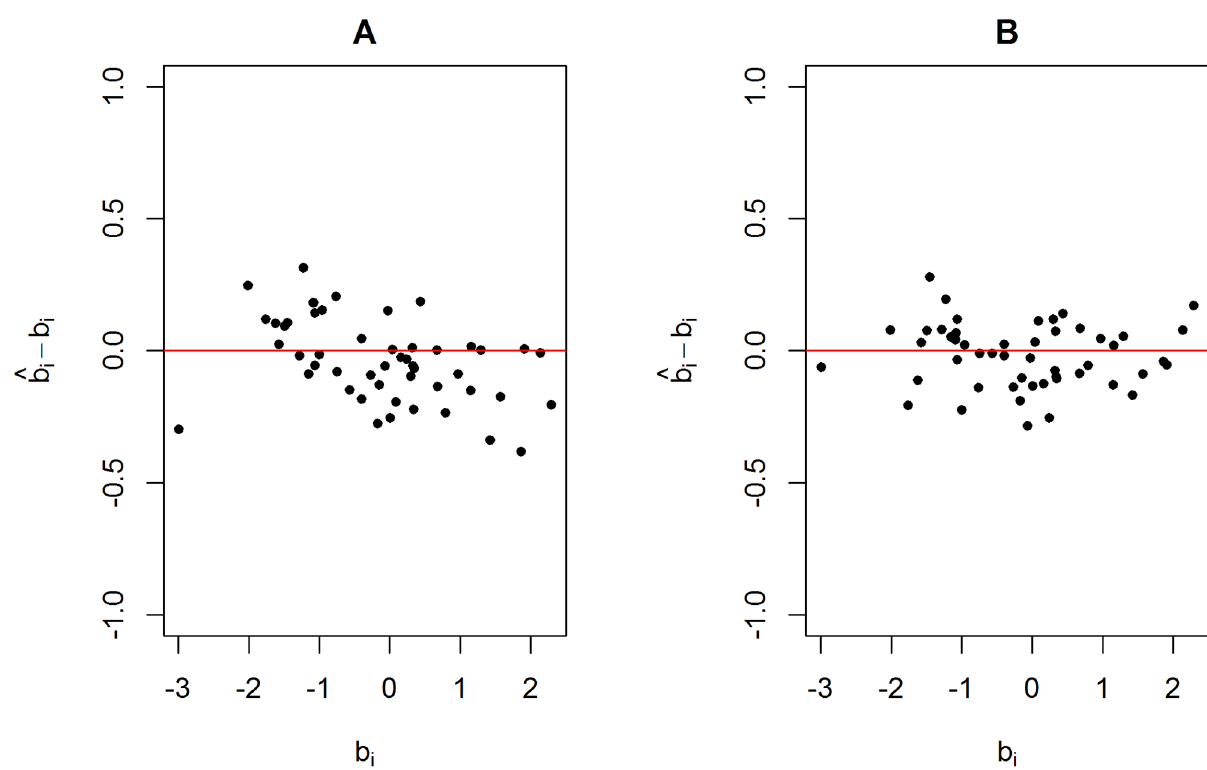
Fig 7. Scatter plot using data generated from scenario 3 with a weight value equal to 10. The differences between the estimated and true item difficulties are plotted against the true item difficulties. (A) Estimated values using the standard Rasch model. (B) Estimated values using the proposed